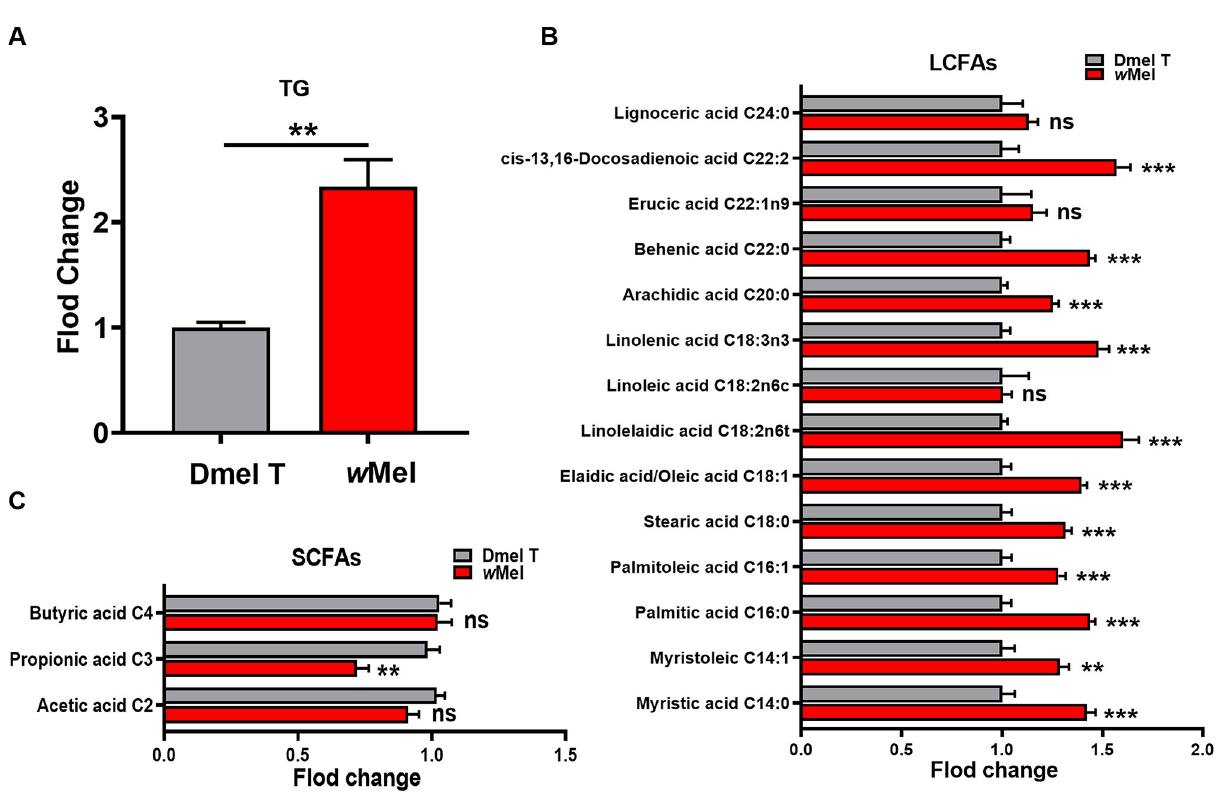
Fig 5. Wolbachia infection influenced lipid metabolism of D . melanogaster . Corresponding measurements of TG in 1d male flies (A). GC-MS analyses of long chain fatty acids (LCFAs) (B) and short chain fatty acids (SCFAs) (C) in 1d males. Dmel T: uninfected flies; w Mel: Wolbachia -infected flies. �� P < 0.01; ��� P < 0.001; ns: not significant.